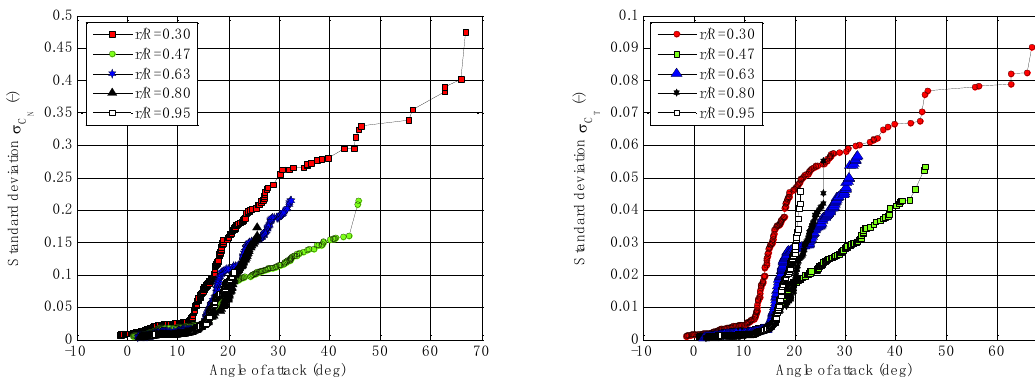
Figure 16. Standard deviations of the normal and tangential force coefficients on the S809 aerofoil section.